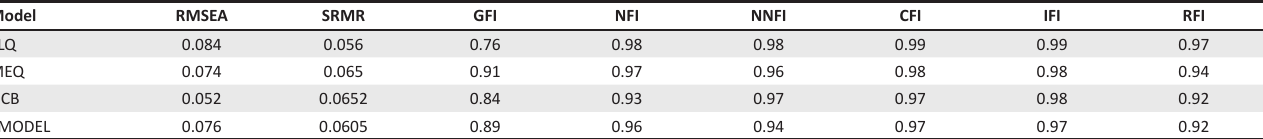
TABLE 4: Goodness-of-fit indices obtained for the servant leadership questionnaire, measuring empowerment questionnaire and organisational citizenship behaviour scale measurement and structural models. Model RMSEA SRMR GFI